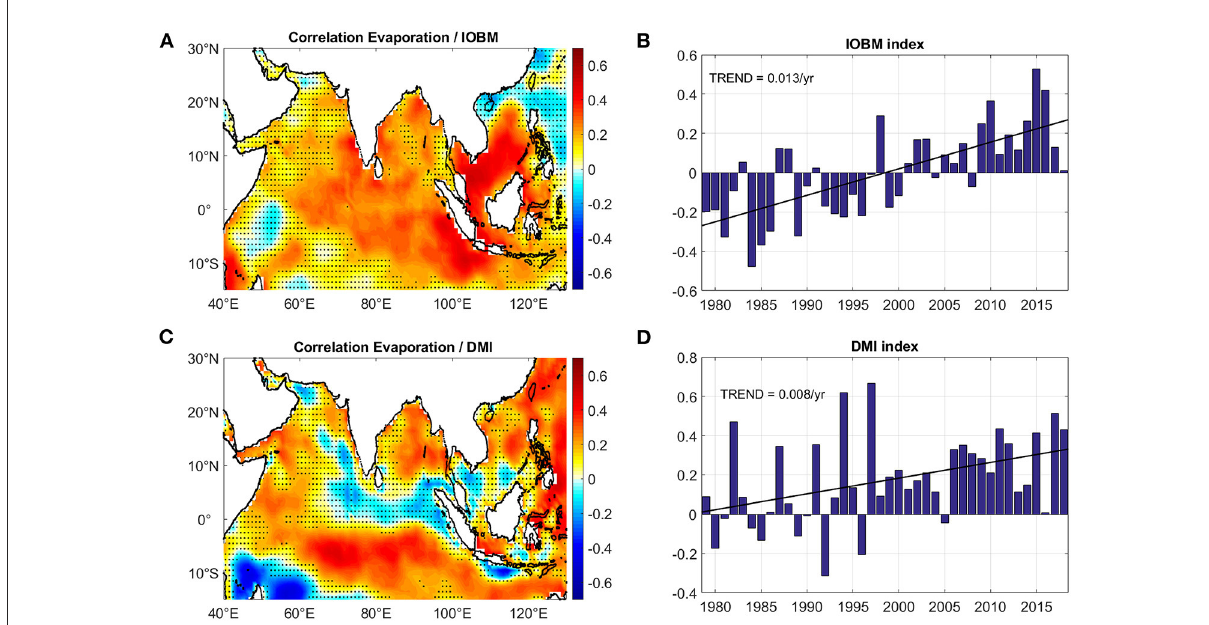
FIGURE13 Correlation spatial patterns between annual mean evaporation (OAFlux) and (A) IOBM, (B) DMI. Regions where the correlation is not significant at the 95 % confidence interval are stippled. Annual timeseries over 1979–2018 of (C) IOBM and (D) DMI. The linear trends (significant at the 90% confidence interval) are also